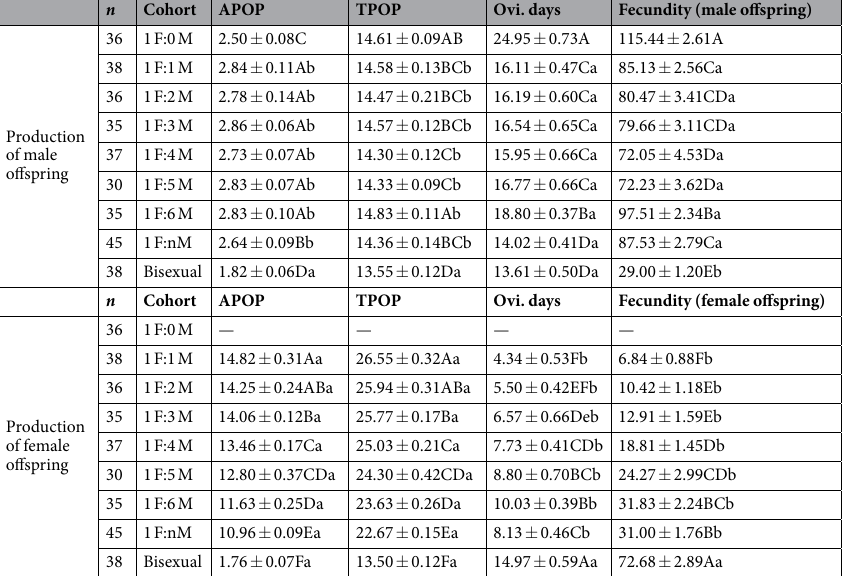
male and female offspring at age 13 d, with the daily fecundity when producing female offspring higher than that when producing male offspring throughout the entire oviposition period (Fig. 2H). In arrhenotokous repro- duction, as the number of oedipal mating males increased, the number and proportion of female offspring also increased (Fig. 2B–H). In the bisexual cohort, no differences were observed between the number of oviposition